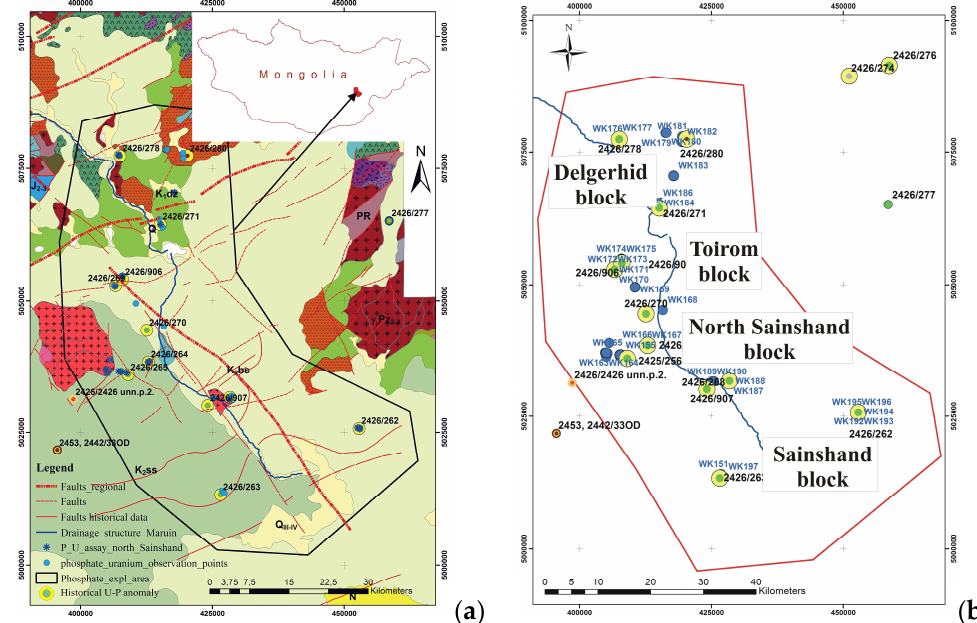
Figure 2. Map of the explored area: ( a ) geological map: granites are red (Mesozoic light red and Paleozoic dark red), Late Jurassic/Early Cretaceous volcanics are orange and Cretaceous sediments are in shades of green. White are areas of salty lakes that are dry in summer. The blue line is the drainage system; ( b ) observation points, historical anomalies—yellow circles with green dots. Blue dots are observation points from recent exploration. Black line polygon is a boundary of the area of interest.